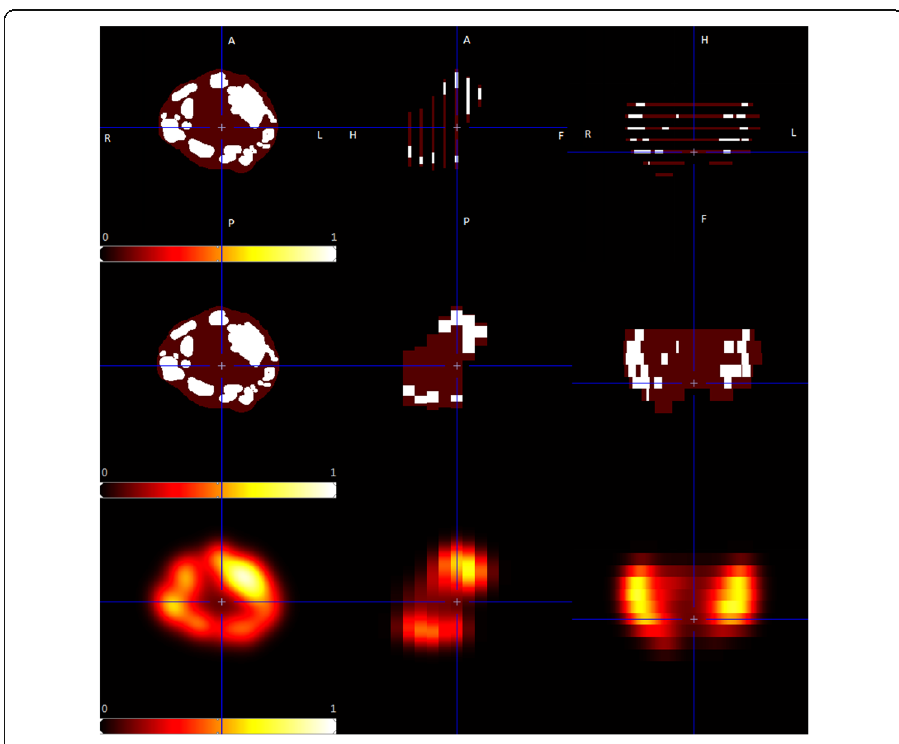
Fig. 2 Procedure for constructing a simulated PET image (histoPET). The histoPET was created from the histopathologic information matched to ex vivo CT (axial, sagittal, and coronal views from left to right). Delineation of PCa (= “ 1 ” ) and non-neoplastic prostate tissue (= “ 0.1 ” ) was performed at every histopathologic slice ( top row ). Note that the transaxial slice thickness of the pathological slices in this row was increased to 1 mm (from originally 2 μ m) for illustration purposes only. The discretized histopathological slices were then used to approximate the entire PCa volume in a 4-mm slice (distance of histopathologic slices, middle row, see also step I) and smoothed in order to account for the limited spatial resolution of PET scans ( bottom row , see also step